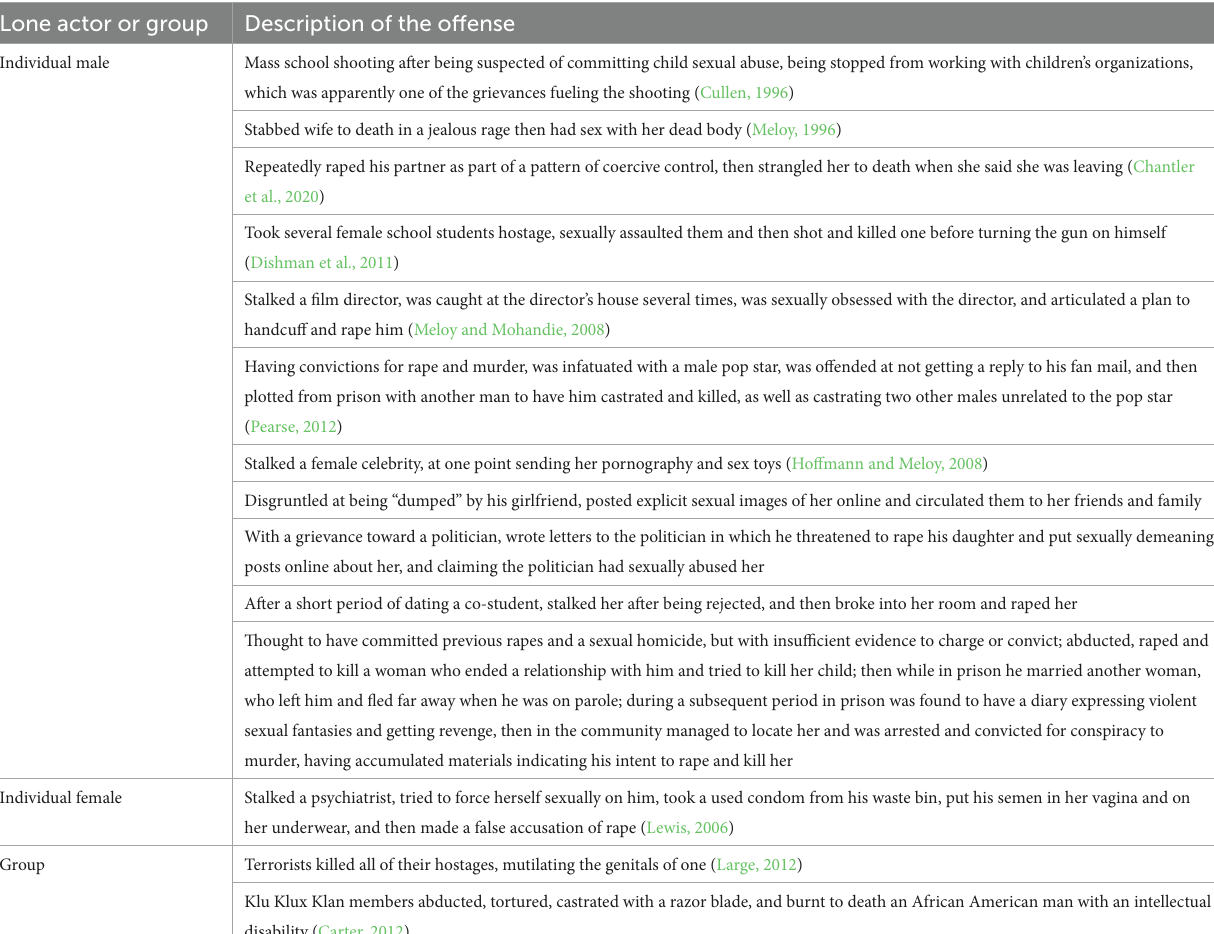
TABLE 1 Examples from the authors’ practice or the public domain of grievance fueled violence involving problems with sexual